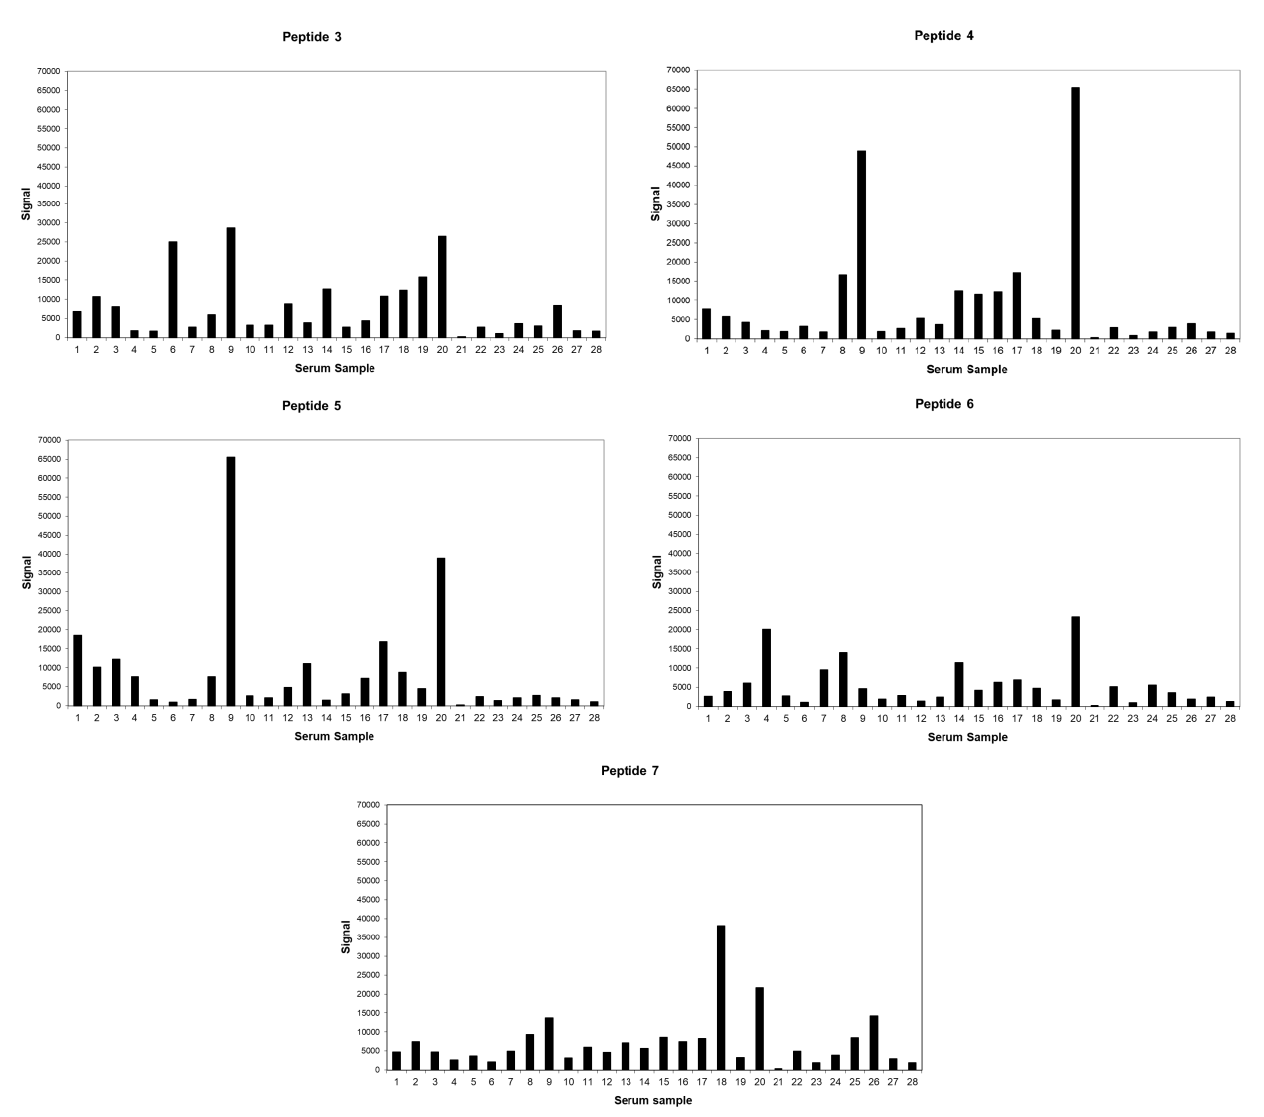
Figure 1. Relative signal intensity of EAV peptides when tested against horse sera. Table 2. EVA peptide sequences and